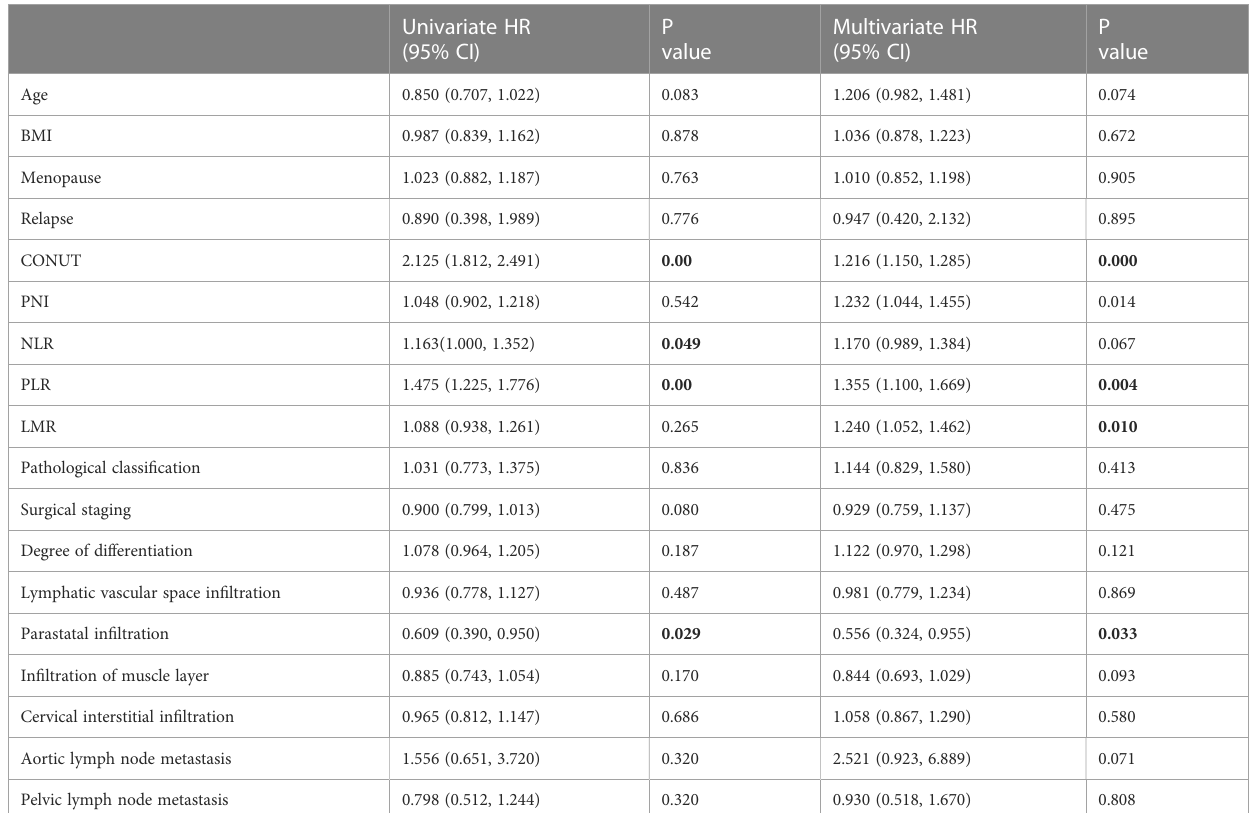
TABLE 5 Univariate and multivariate Cox regression analyses of EC prognostic